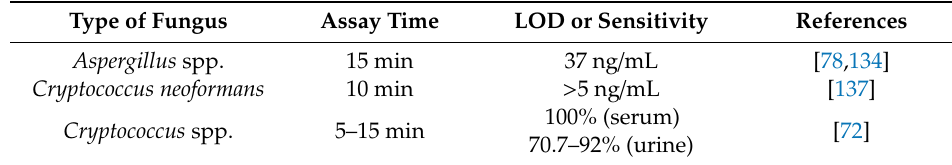
Table 1. Immunochromatographic tests for clinically relevant fungal species. Type of Fungus Assay Time LOD or